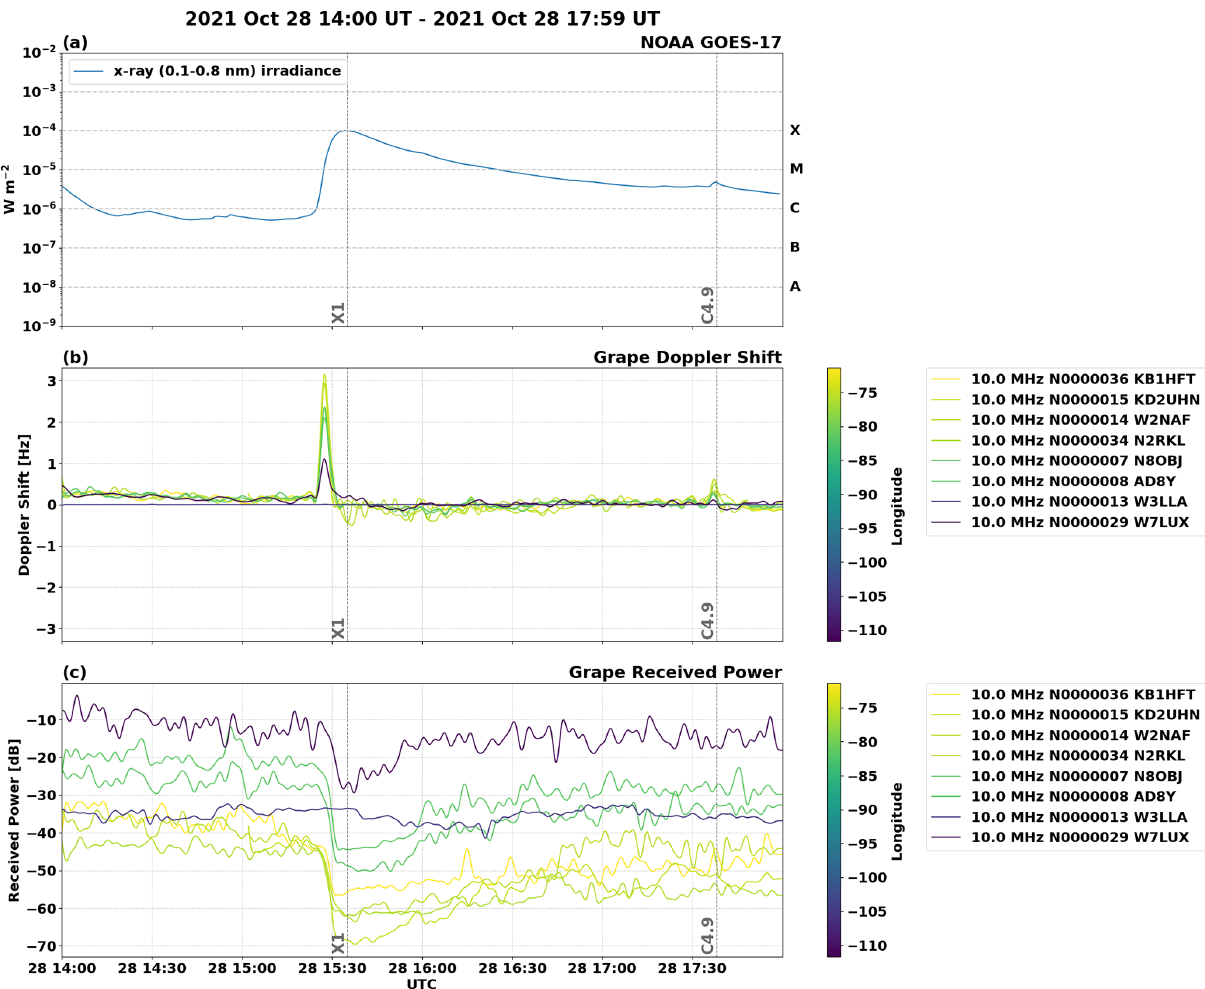
Figure 9. Annotated frequency and amplitude plots showing the response of Grape stations on 10MHz to an X1 solar flare on 28 Octo- ber 2021. The single-node measurement of this event on 5MHz in Fig. 5 is corroborated by other nodes in the Grape network, as well as by the SuperDARN measurement in Fig. 10.